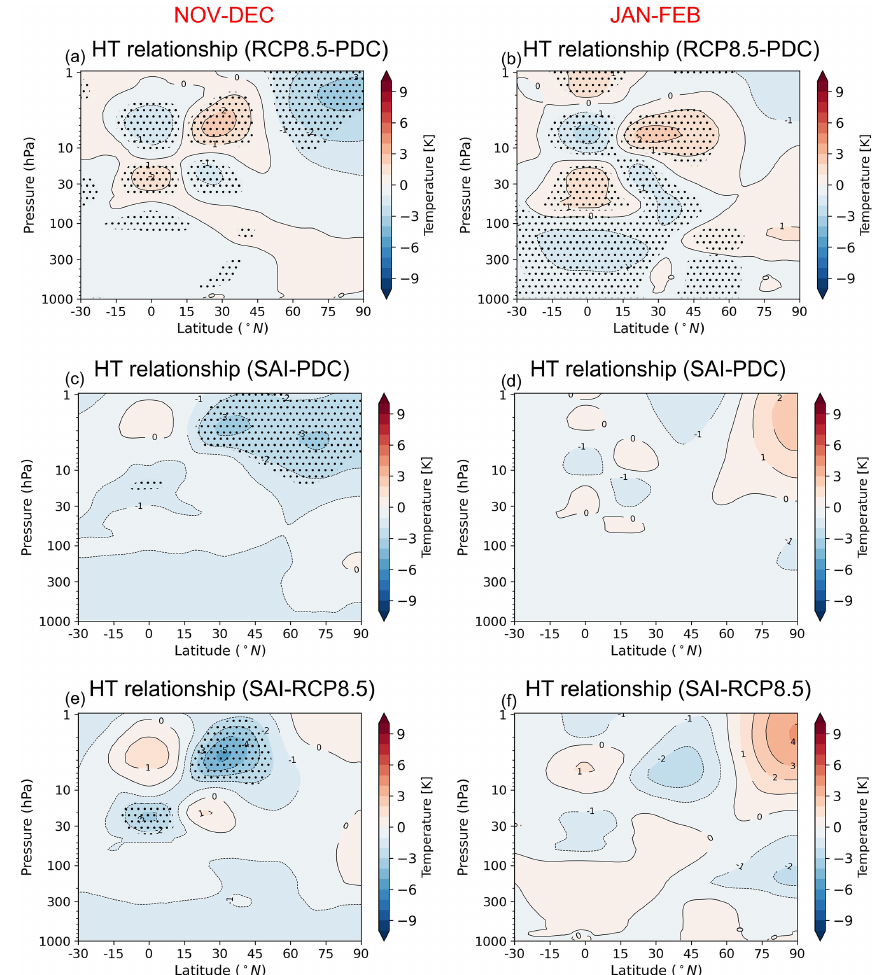
Figure 6. The same as Fig. 5 but for the zonal mean